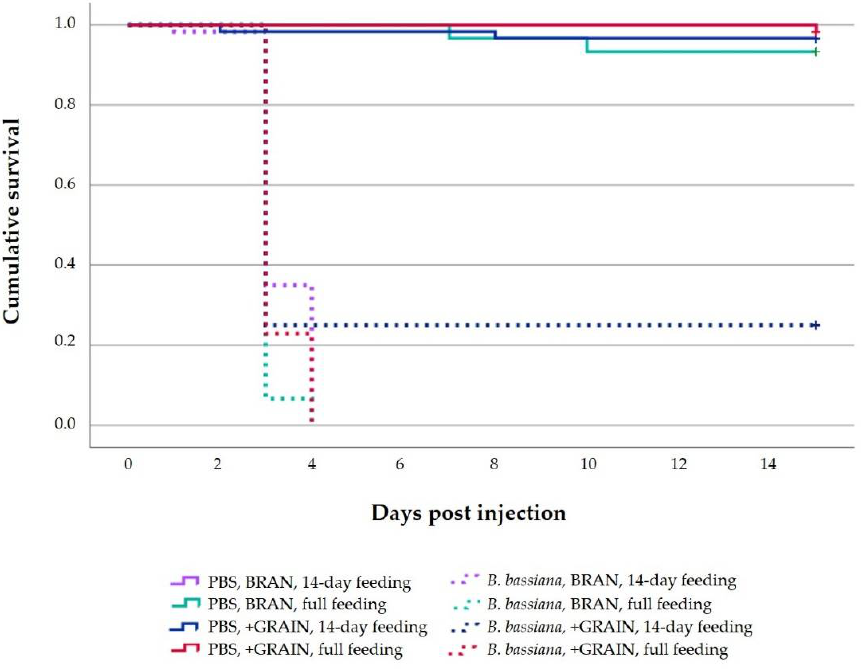
Figure 3. Survival curve according to Kaplan–Meier analysis of larvae fed different diets (BRAN, +GRAIN) for different timings of diet administration (14-day feeding, full feeding) after injection with PBS or B. bassiana . The survival lines of “PBS, BRAN, 14-day feeding” and of “PBS, +GRAIN, full feeding” coincide perfectly. Therefore, only the “PBS, +GRAIN, full feeding” line is evident. Censored cases are indicated by a cross.